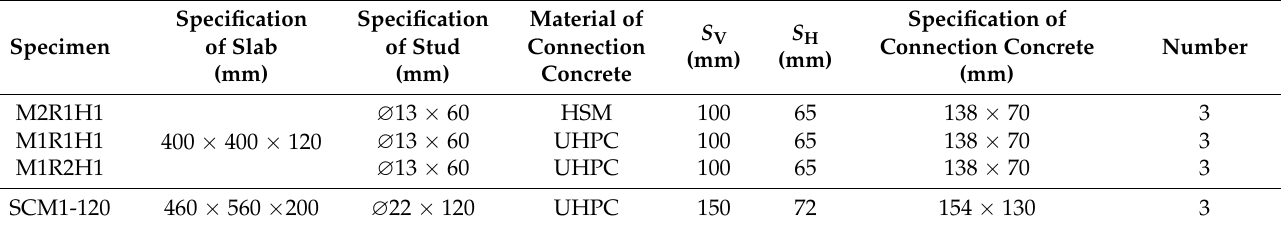
Table 1. Summary of experiments details and